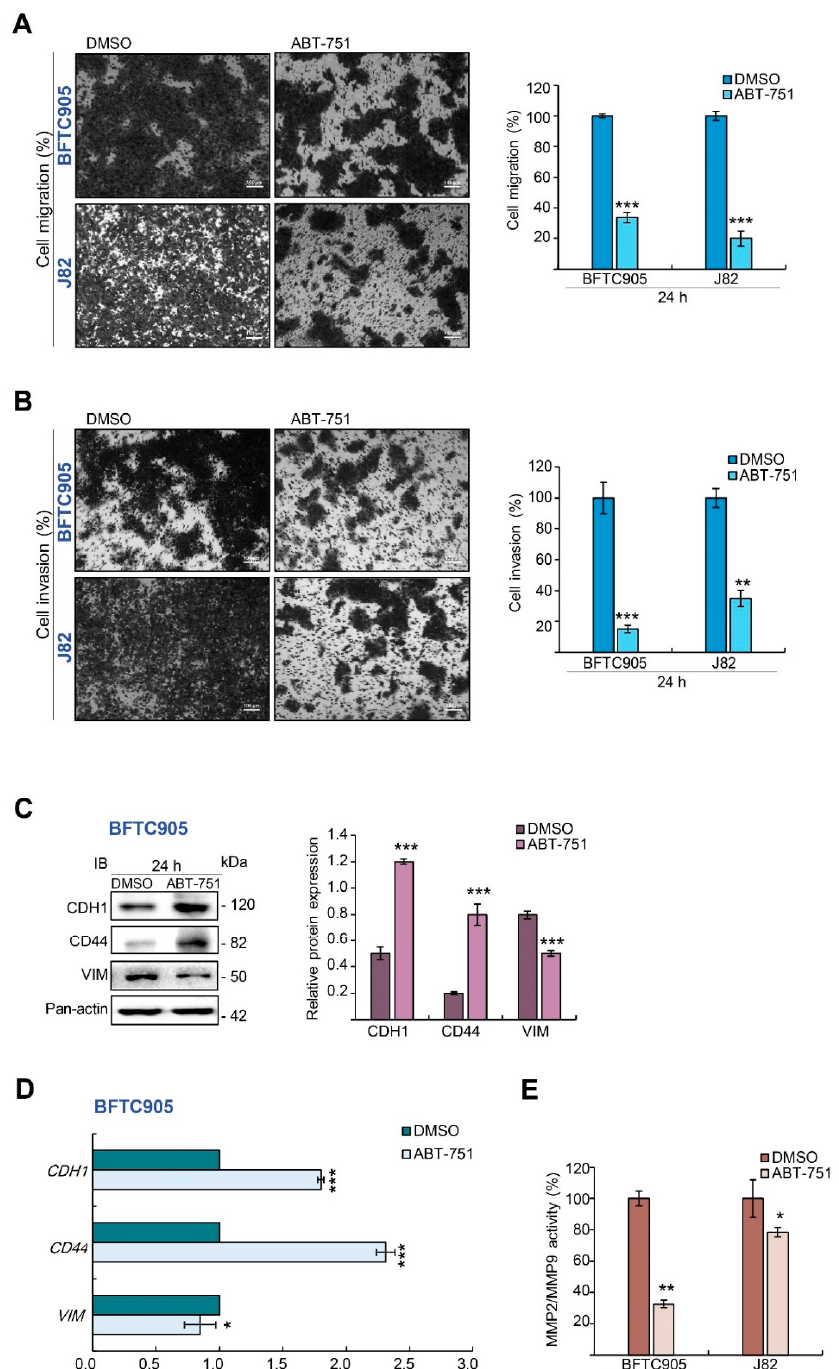
Figure 2. ABT-751 inhibits migration and invasion in UBUC cell lines. ( A , B ) The cells were treated with specified concentrations (BFTC905, 0.6 µ M and J82, 0.7 µ M) of ABT-751 for 24 h and cell migration and invasion were analyzed using the QCM ECMatrix Kit. Scale bar: 100 µ m. ( C , D ) BFTC905 cells were treated with ABT-751 (0.6 µ M) for 24 h; the levels of several migration and invasion-associated proteins and mRNA were examined by Immunoblots and quantitative RT-PCR, respectively. ( E ) Both UBUC-derived cell lines were treated with a specified concentration of ABT-751 (BFTC905, 0.6 µ M and J82, 0.7 µ M). Next, MMP2/MMP9 activity was analyzed by gelatinase activity assays. Relative protein expression of the indicated proteins was quantified using ImageJ software. The results are expressed in the means ± SD. Pan-actin served as a loading control in each gel for immunoblot analysis. Statistical significance: * p < 0.05, ** p < 0.01, *** p <